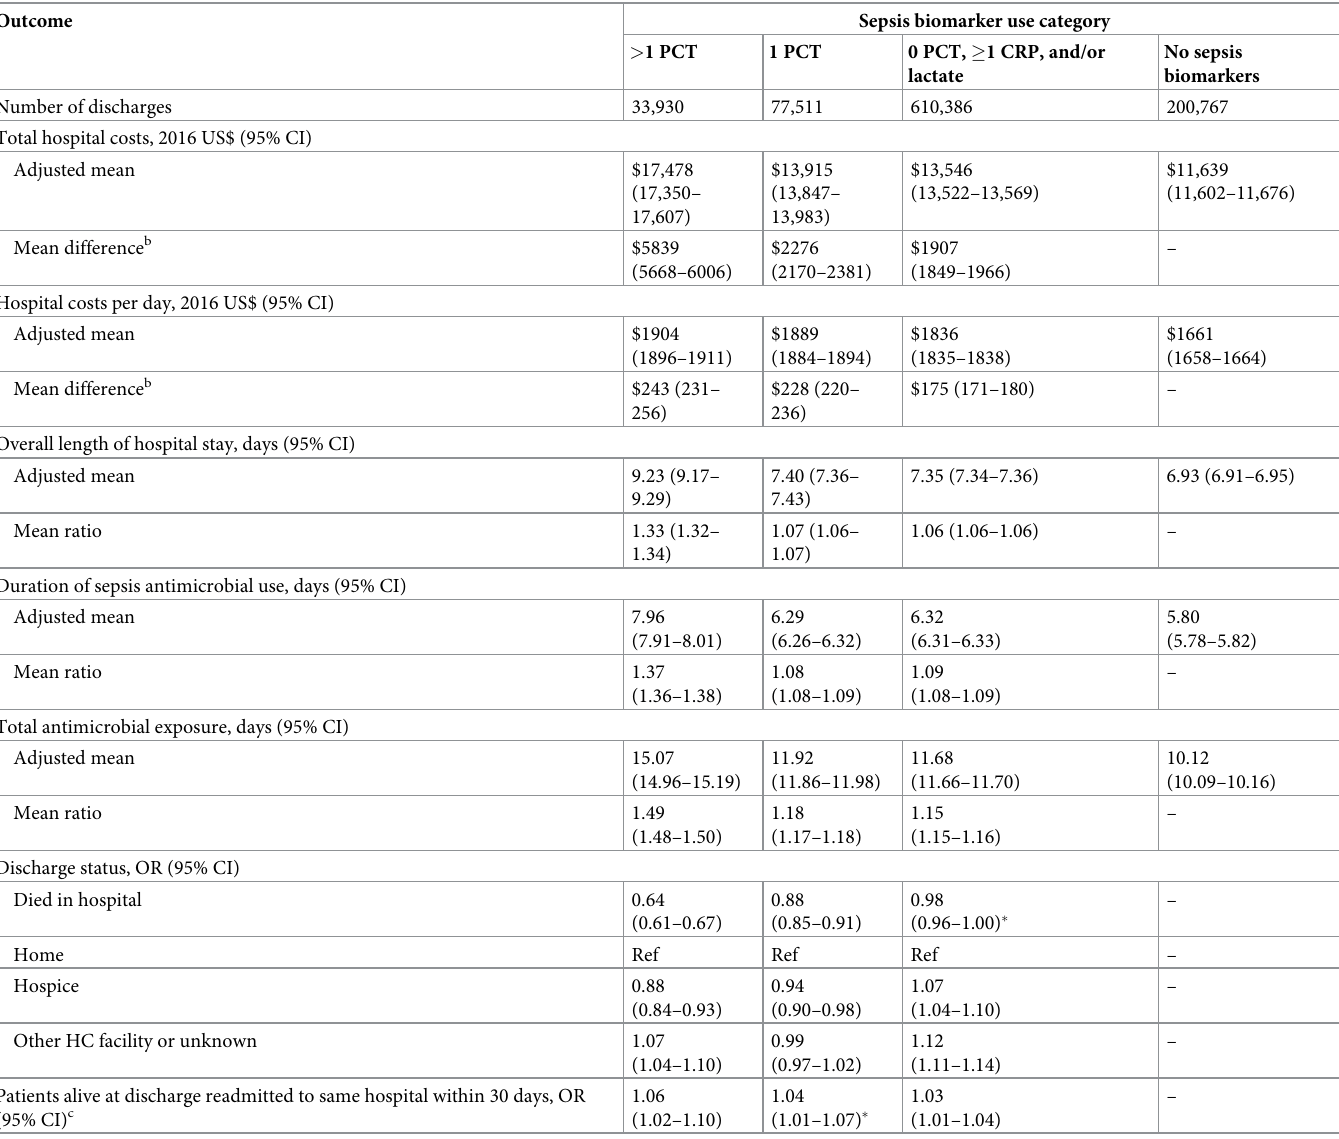
Table 4. Adjusted outcomes for sepsis discharges by biomarker use category a (N = 922,594).